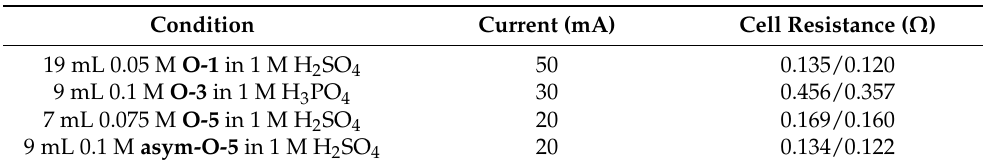
Figure A2. Capacity decay rate of O-1 in different supporting electrolytes (H 3 PO 4 or H 2 SO 4 ), using PS and GSH (galvanostatic with potential hold) cycling methods. Table A1. Condition, charge/discharge current and cell resistance of the symmetric cell cycling tests using the GS cycling method.